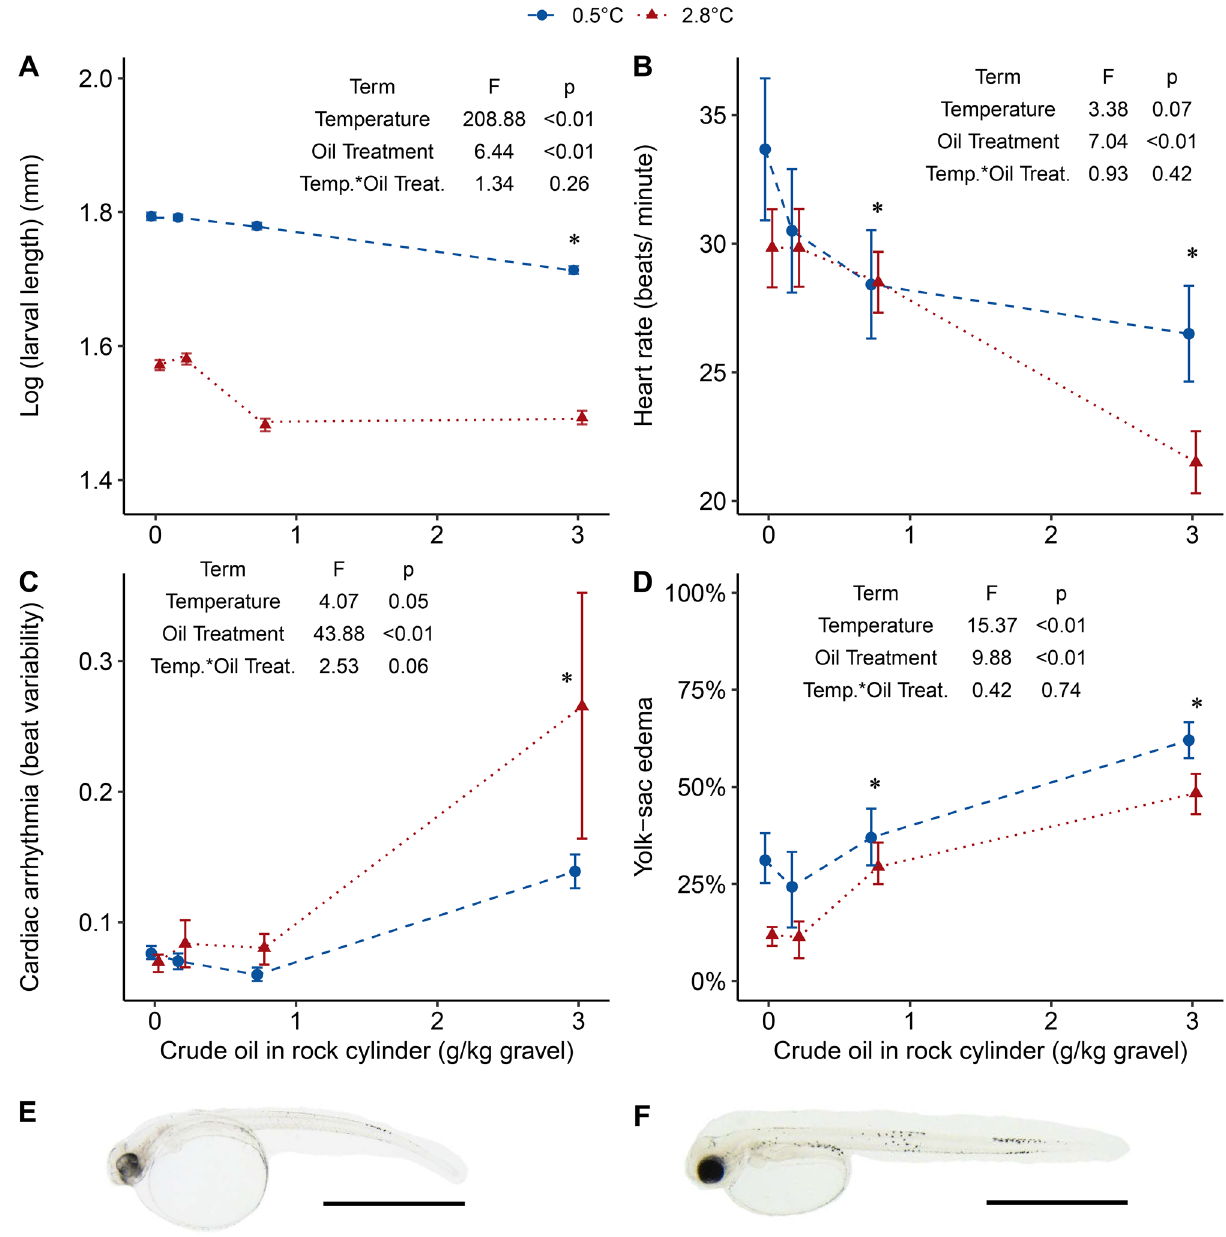
Figure 6. The effects of temperature and WSF crude oil exposure on yolk sac larvae: ( A ) log (length in mm) at day 28 for 2.8 °C and day 50 for 0.5 °C; ( B ) heart rate and ( C ) cardiac arrhythmia at day 29–30 for 2.8 °C and Day 47–48 for 0.5 °C displayed as interbeat variability; ( D ) the prevalence of yolk sac edema; ( E ) a warm-reared unexposed larvae; and ( F ) a cold-reared unexposed larvae at day 28 for 2.8 °C and day 50 for 0.5 °C with a scale bar representing 2 mm. Fitted dashed lines are the results of gls models using incubator as a random factor for panel ( A – C ). For all panels, colors, line types, and shapes distinguish temperature groups and treatment means are plotted [± SEM depicted as bars, each point includes four incubator means calculated from 30 larvae (panel A ) or three larvae each (panel B and C )] per incubator. Panel ( D ) presents treatment means (± SEM depicted as bars, each point includes deformity scores ( i.e., percentage of larvae afflicted) from four incubators) and the fitted line is a result of the LME model using incubator as a random factor. The terms of the GLS model for larval length, heart rate and arrhythmia and the lme model for prevalence of yolk-sac edema are displayed in the respective panels with the ANOVA test F-values and p-values. An asterisk (*) above a treatment group indicates a statistically significant difference from the unexposed group. In panel ( E ) and ( F ), the scale bar is 2